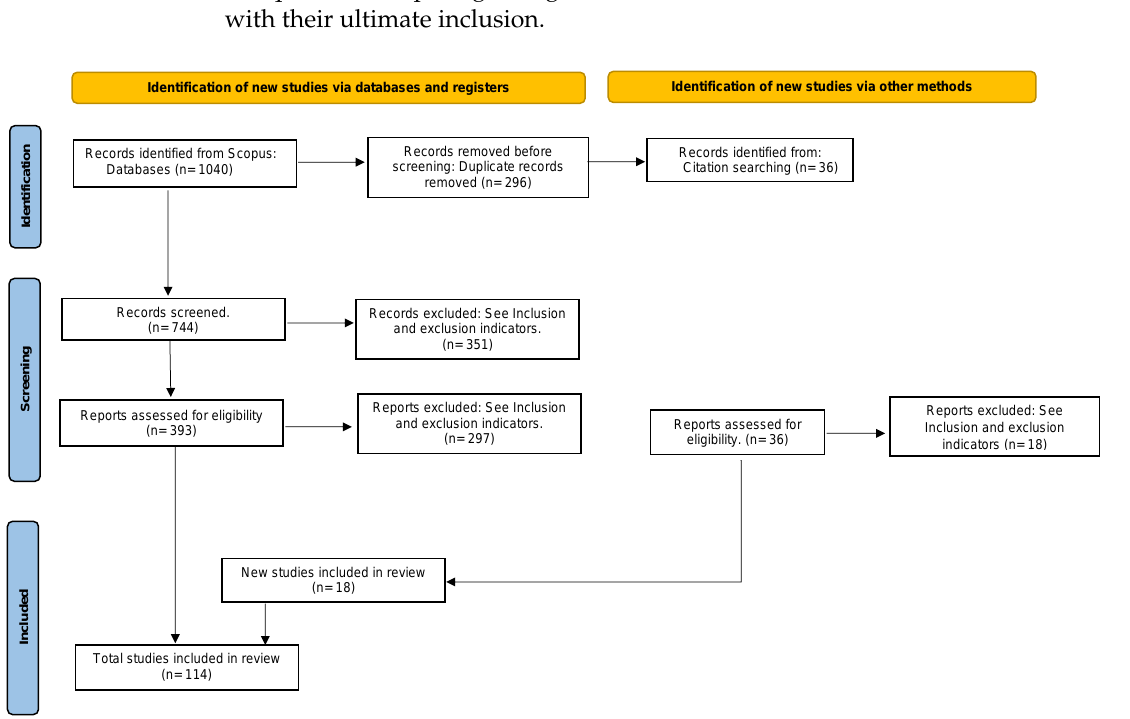
Figure 2. PRISMA 2020 diagram of study selection